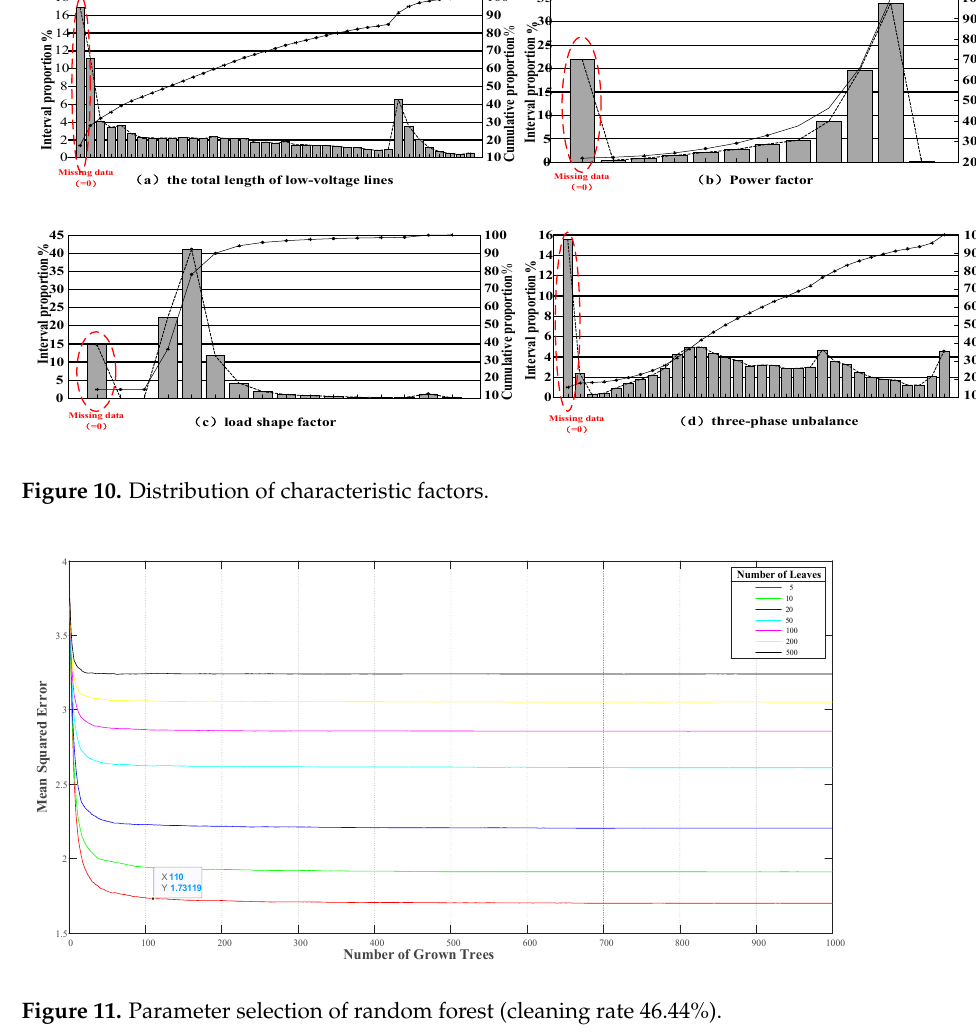
Figure 11. Parameter selection of random forest (cleaning rate 46.44%).